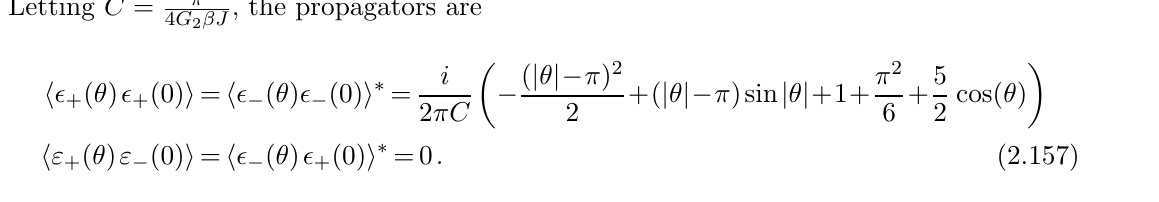
Figure 5 . The two one-loop diagrams that correct the two-point function at O (1 =C ) = O ( G 2 ). Letting C